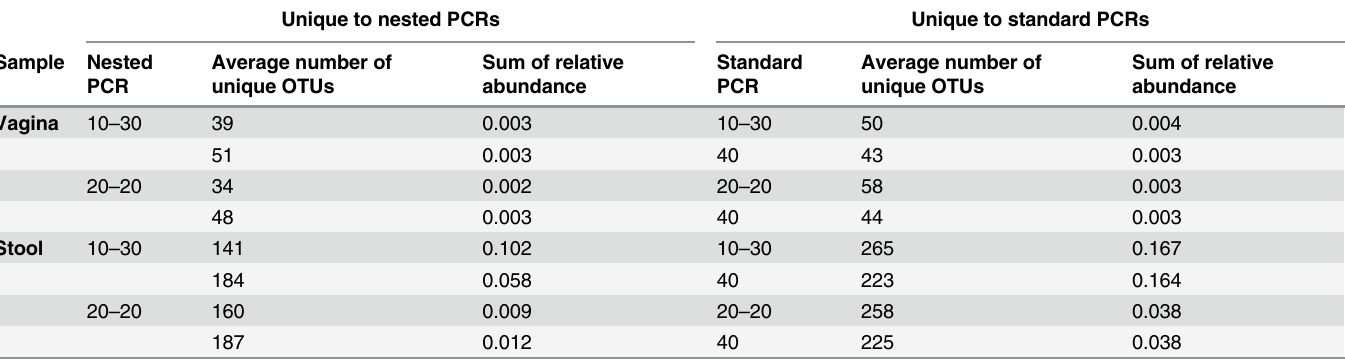
Table 2. Summary of number of OTUs which were detected by only either nested PCRs or standard PCR controls when compared with each other for the matched